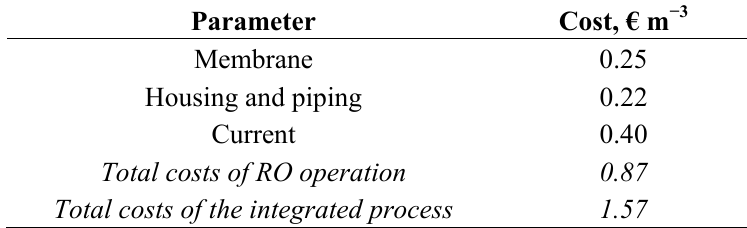
Table 7. Cost evaluation of RO operation and whole integrated process.